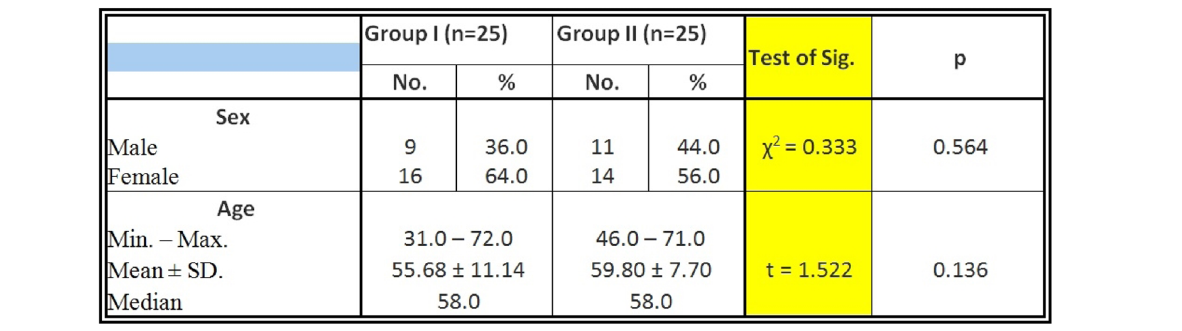
Table 1 Comparison between the studied groups as regard the demographic data